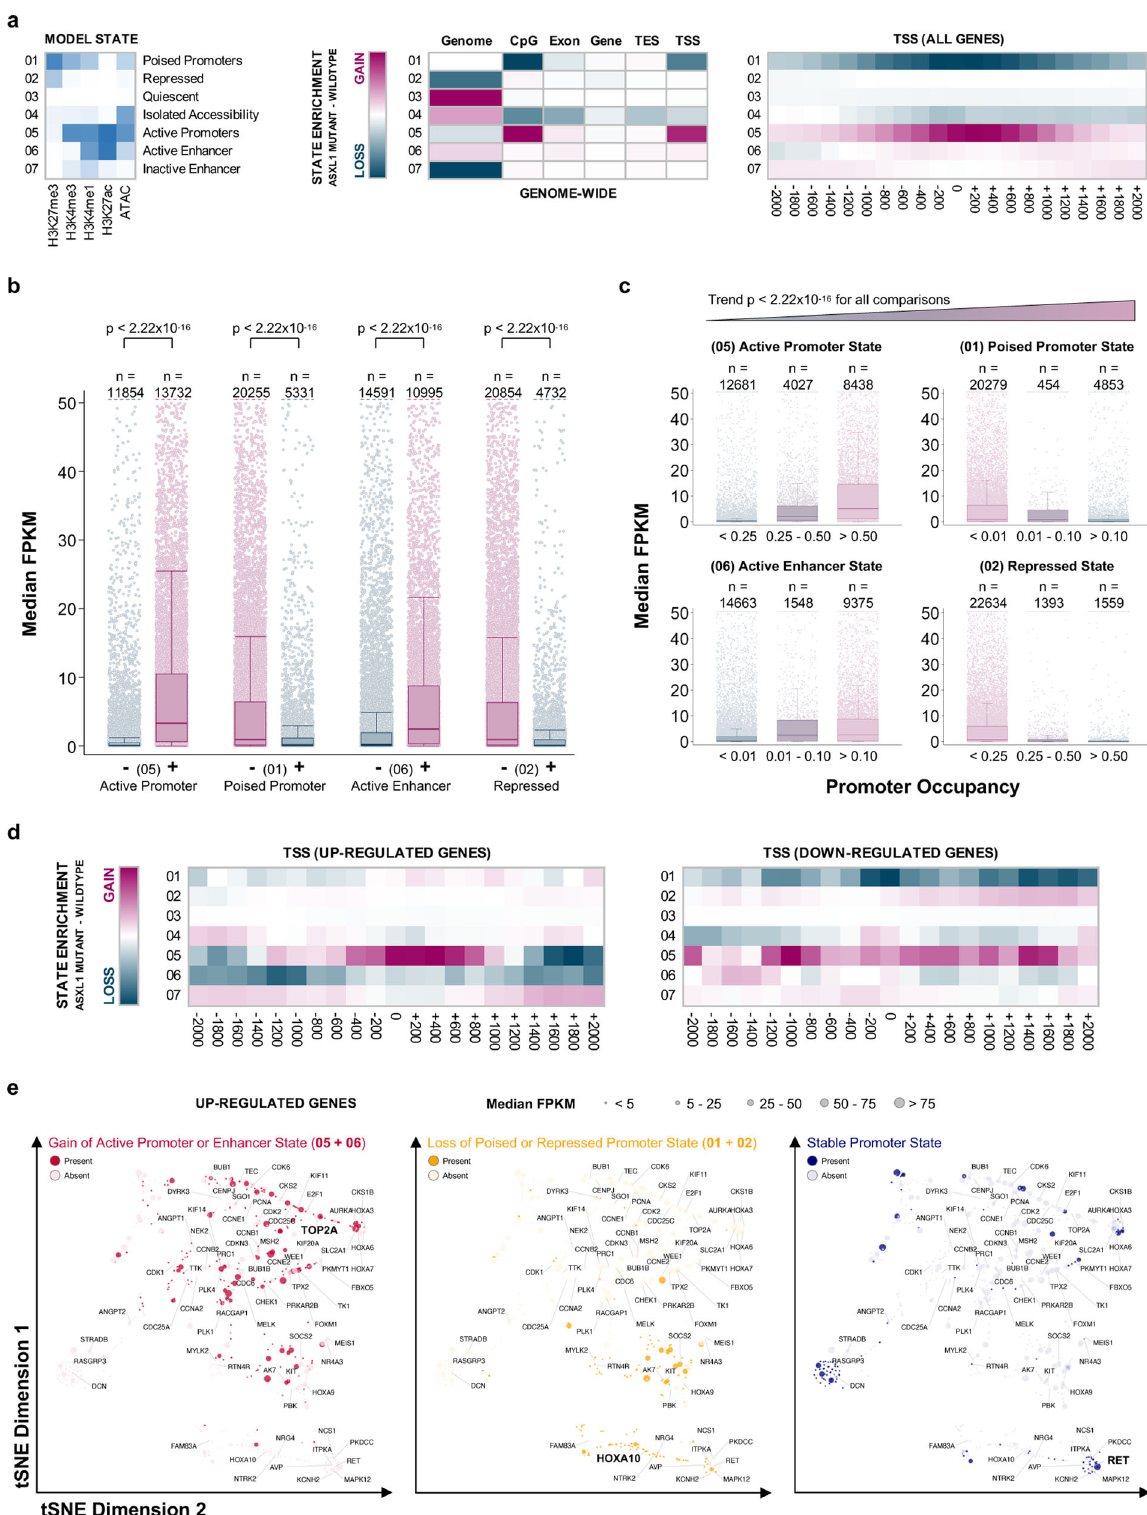
body methylation. A measure of the relative importance of the different epigenetic regulatory mechanisms is shown in Supple- mentary Fig. 5c. Relevant regression diagnostics for the model are shown in Supplementary Fig. 5d – f. These data support the notion that ASXL1 MT -speci fi c distal enhancers are independently asso- ciated with increased oncogenic gene expression and their pre- sence can serve as a plausible explanation for the